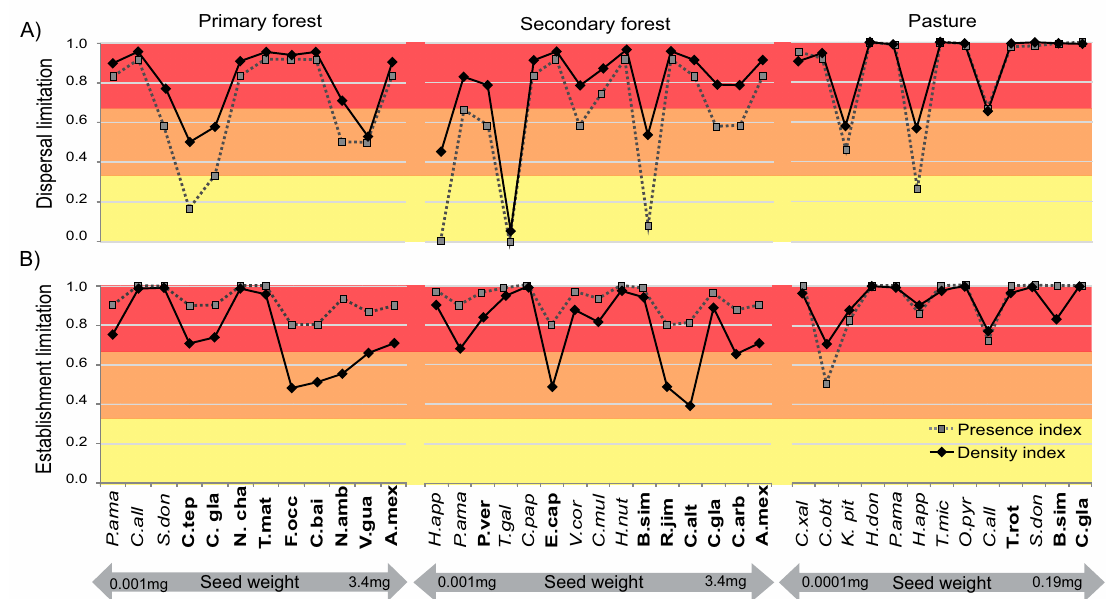
Figure 4. Graphic representation of the differences between the presence and the density-weighted index. The connecting line is only to show how a general tendency is followed for both indexes. Wald-Wolfowitz Runs test indicated highly significant differences for both ( A ) dispersal and ( B ) establishment limitation between indices. Limitation from 0% to 33% was classified as low (yellow), from 34% to 66% as intermediate (orange) and 67% to 100% as high (red). Acronyms refer to the first letter of the genus and the three first letters of the species (full species names are included in Table A1). Pioneer species are marked in bold while and non-pioneer species are marked with italics.